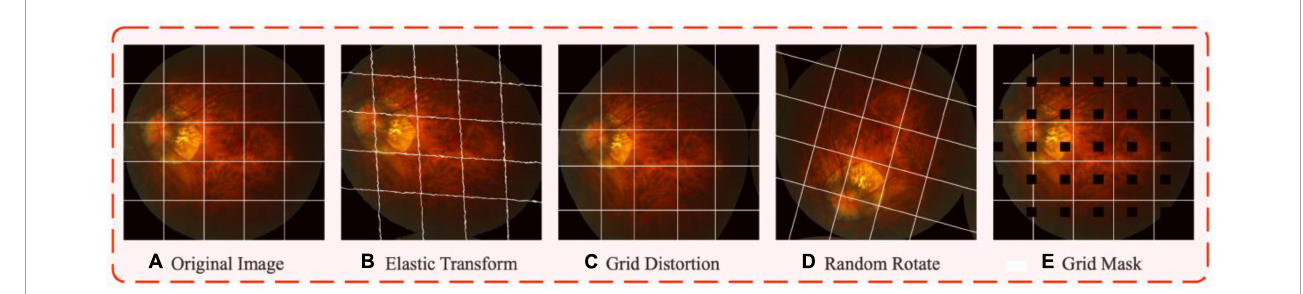
FIGURE4 The visualized results after data augmentations. Subplot (A) is the sample of fundus images in iChallenge-PM dataset, the white grid line added to the original graph is to better show the effect of different augmentation. Subplot (B–E) represents elastic transform, grid distortion, random rotate, and grid mask, respectively.